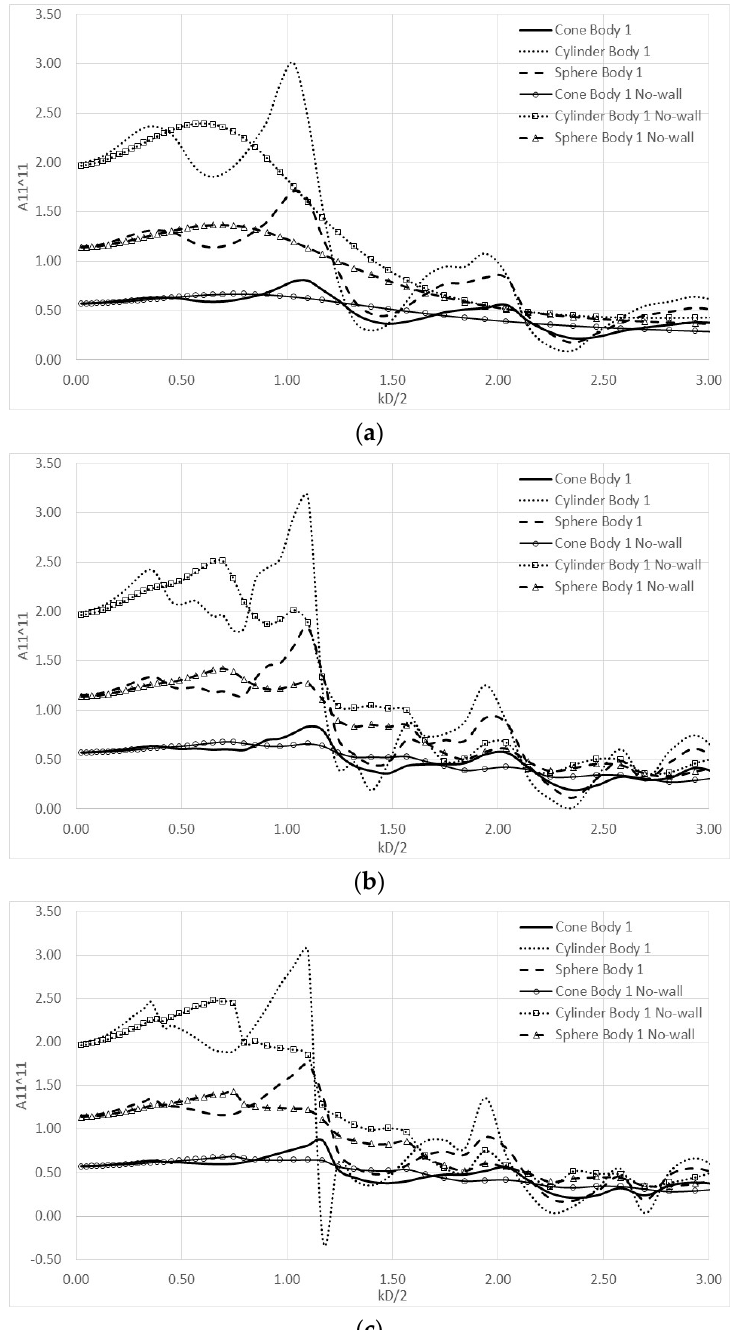
Figure 11. Dimensionless added mass of the 1st floater at the surge direction due to its motion at surge against kD / 2, for the three di ff erent examined array configurations. Comparison with the corresponding added mass on the same floater of the arrays without the presence of the breakwater: ( a ) parallel arrangement, C 1 ; ( b ) rectangular arrangement, C 2 ; ( c ) perpendicular arrangement, C 3